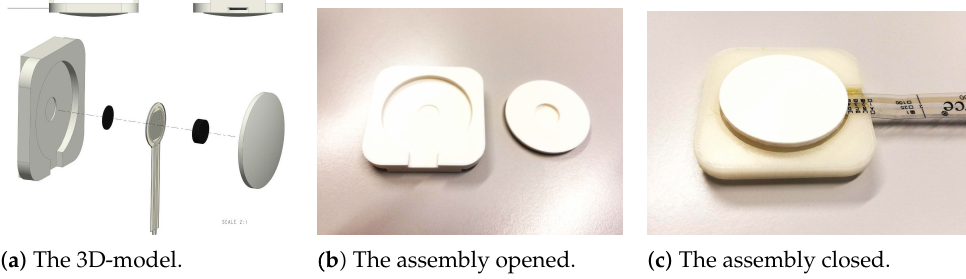
Figure 4. The 3D-model and the printed model of the round shape, assembled with the sensors.